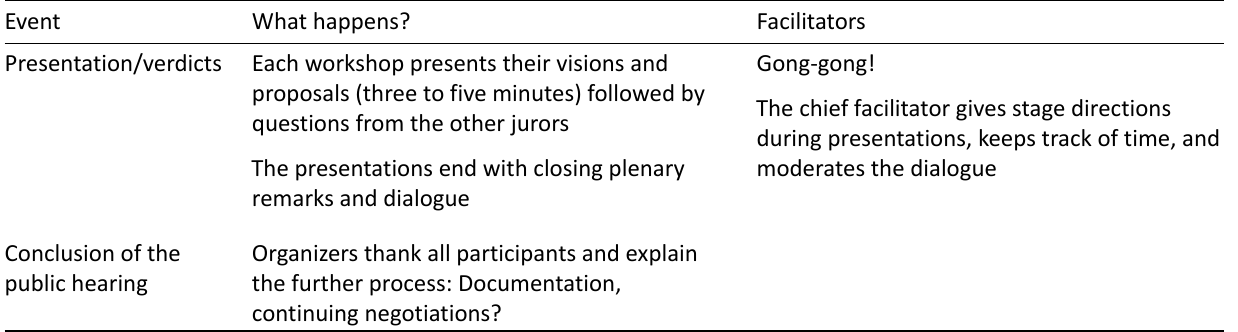
Table 1. (Cont.) Free Trial! dramaturgical script.